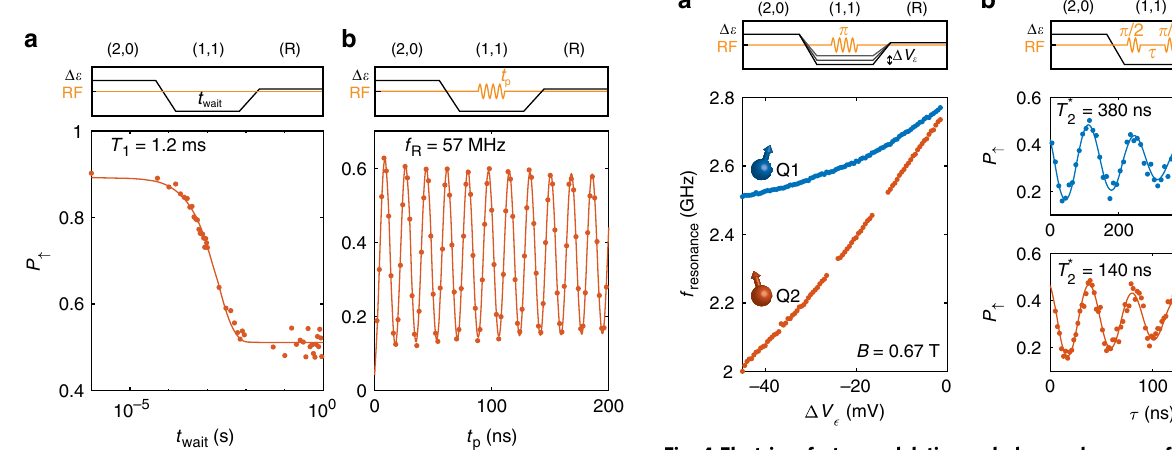
Fig. 4 Electric g-factor modulation and phase coherence of the qubit resonances. a The resonance frequency of both qubits shows a strong modulation as a function of the detuning voltage Δ V ϵ . b We perform a Ramsey experiment on both qubits to probe the phase coherence times, ¼ 380 ns and T (cid:3) ¼ 140 ns. The comparatively short phase with T (cid:3) 2 ; Q 1 2 ; Q 2 coherence can be attributed to the strong dependence of f resonance to electric fi elds, coupling charge noise to the spin state, leading to increased